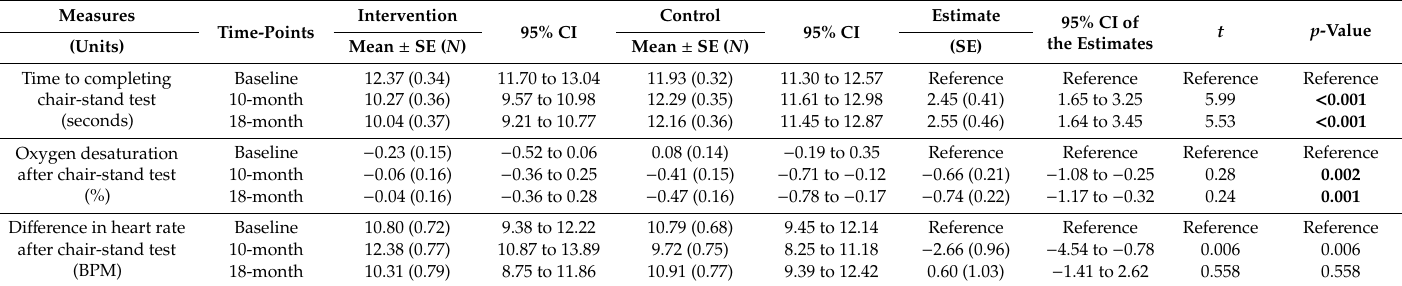
Table 3. Adjusted models for secondary outcomes: functional measures.